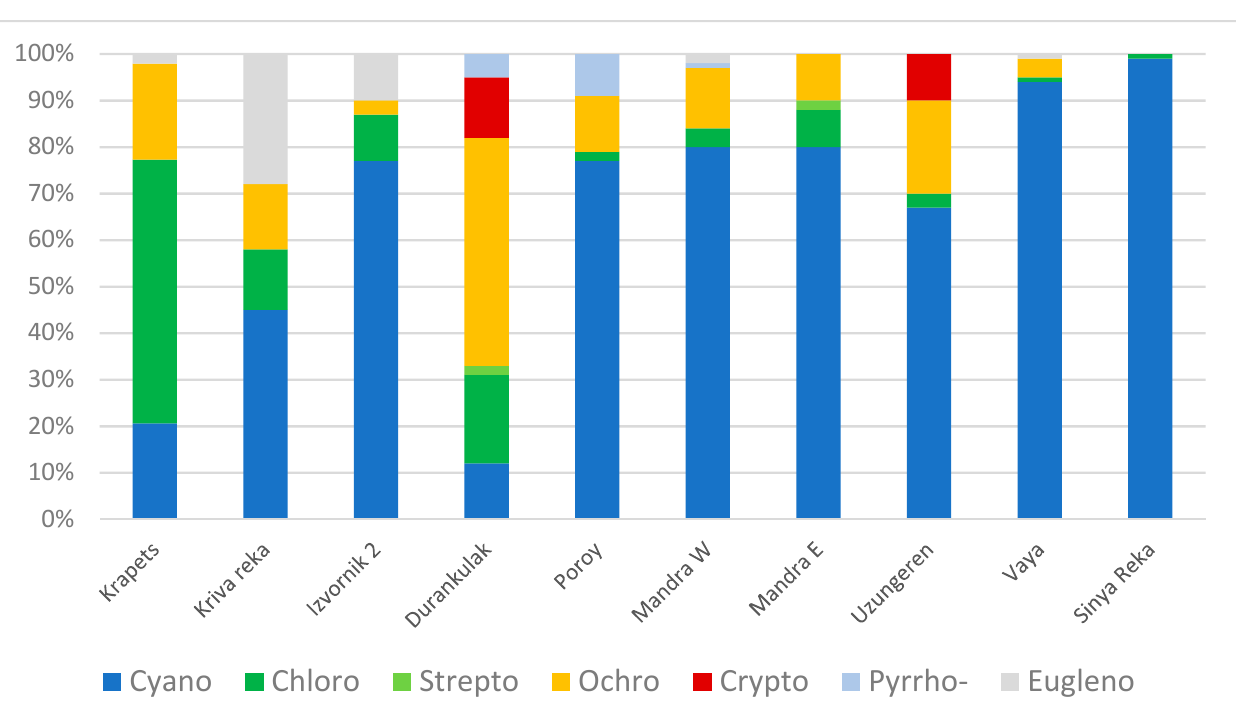
Figure 4. Relative contribution of different taxonomic groups to phytoplankton biomass, obtained by light microscopy, in the phytoplankton of the studied Bulgarian water bodies (August 2019). Legend: Mandra W—western part of the reservoir Mandra, Mandra E—eastern part of the reservoir Mandra; Cyano—Cyanoprokaryota, Chloro—Chlorophyta, Strepto—Streptophyta, Ochro—Ochrophyta (mainly diatoms), Crypto—Cryptophyta, Pyrrho—Pyrrhophyta and Eugleno—Eu ‐ glenophyta.